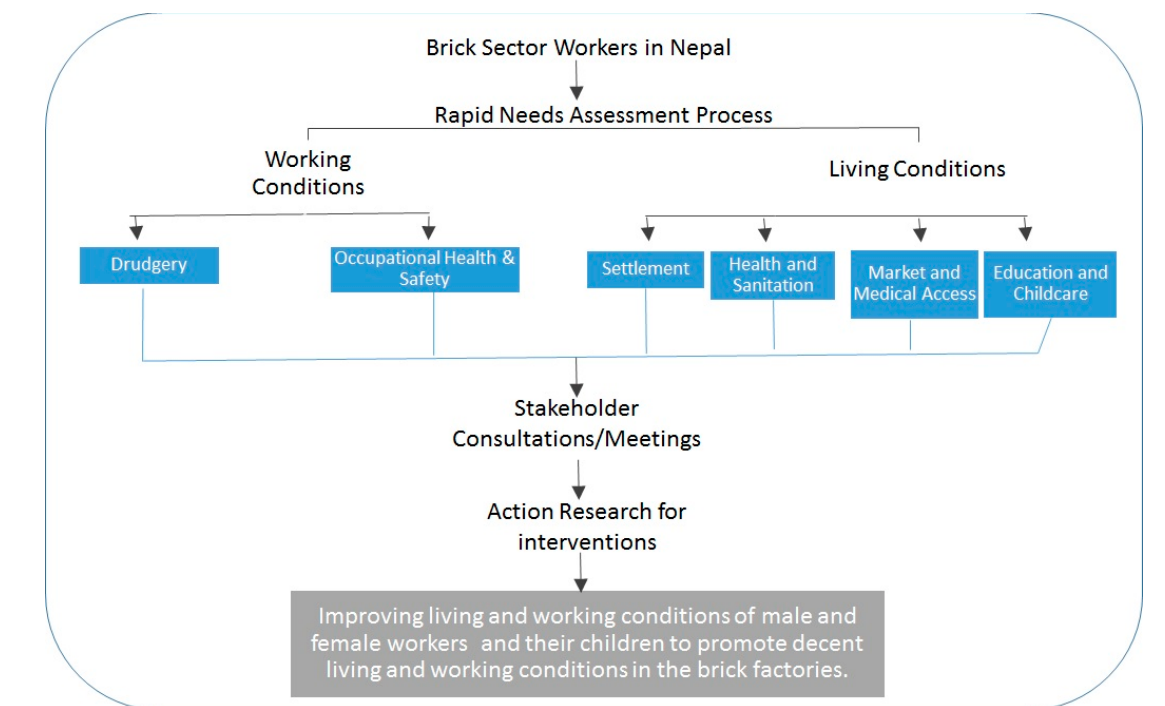
Figure 1. Conceptual framework.